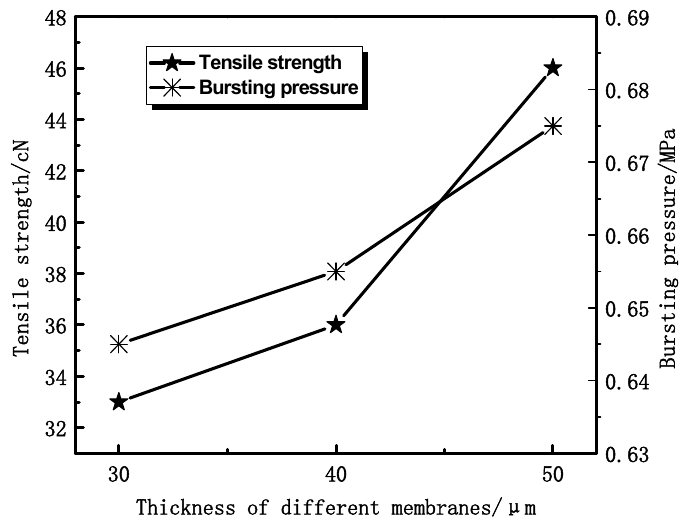
Figure 7. The effect of thickness on tensile strength and bursting